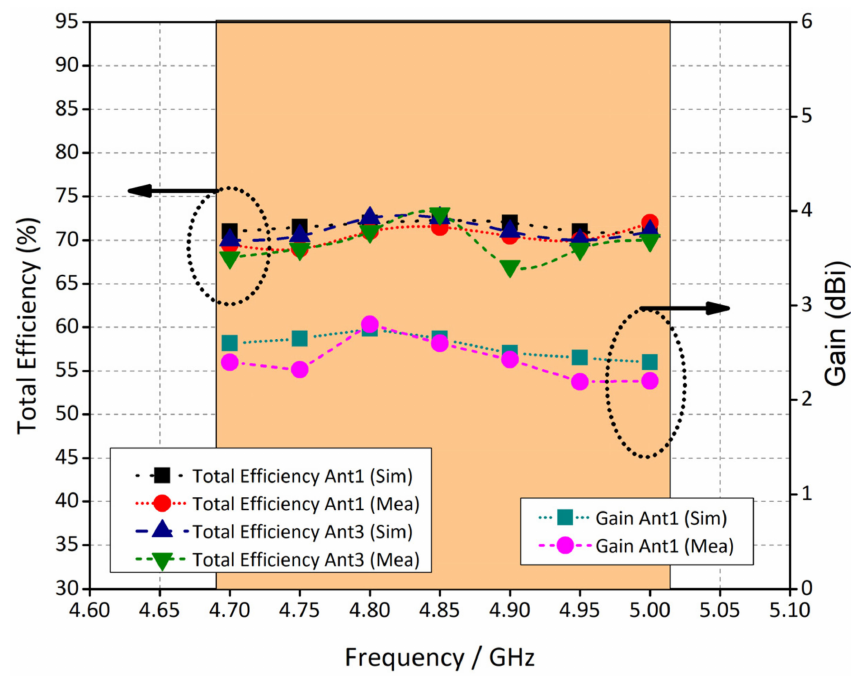
Figure 8. Antenna performance